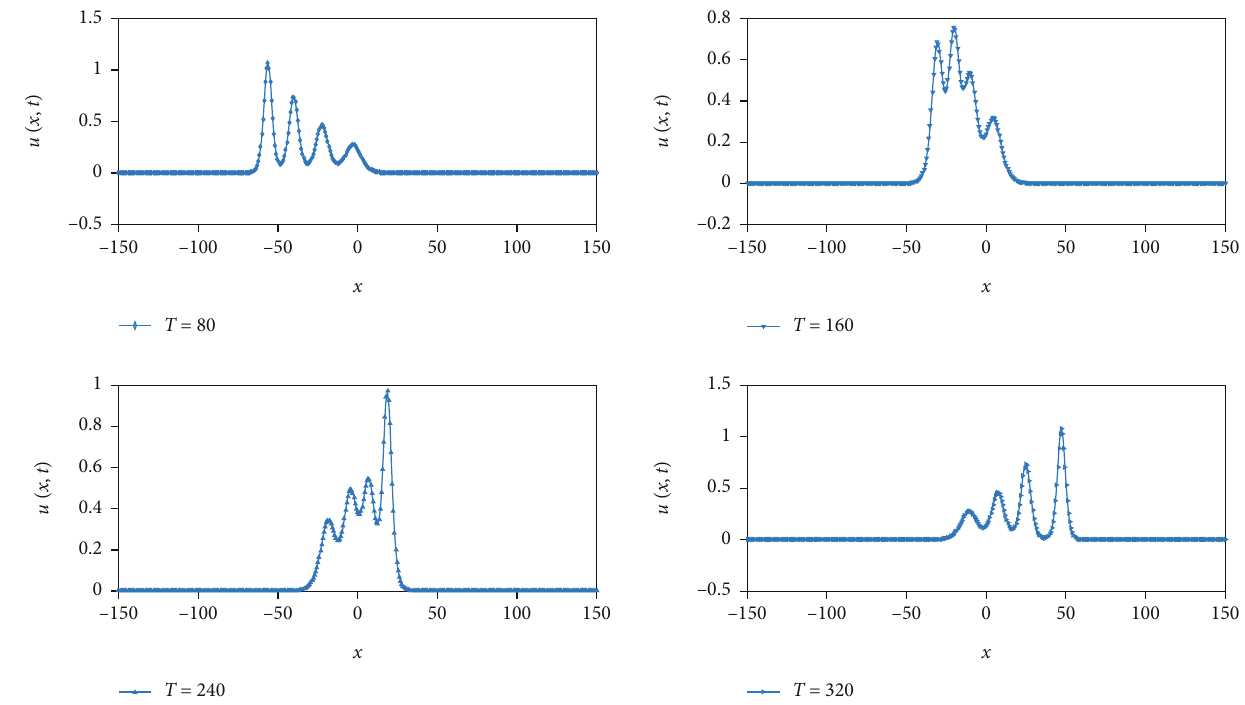
Figure 5: Simulations of four solitons at Δ t = 0 : 1